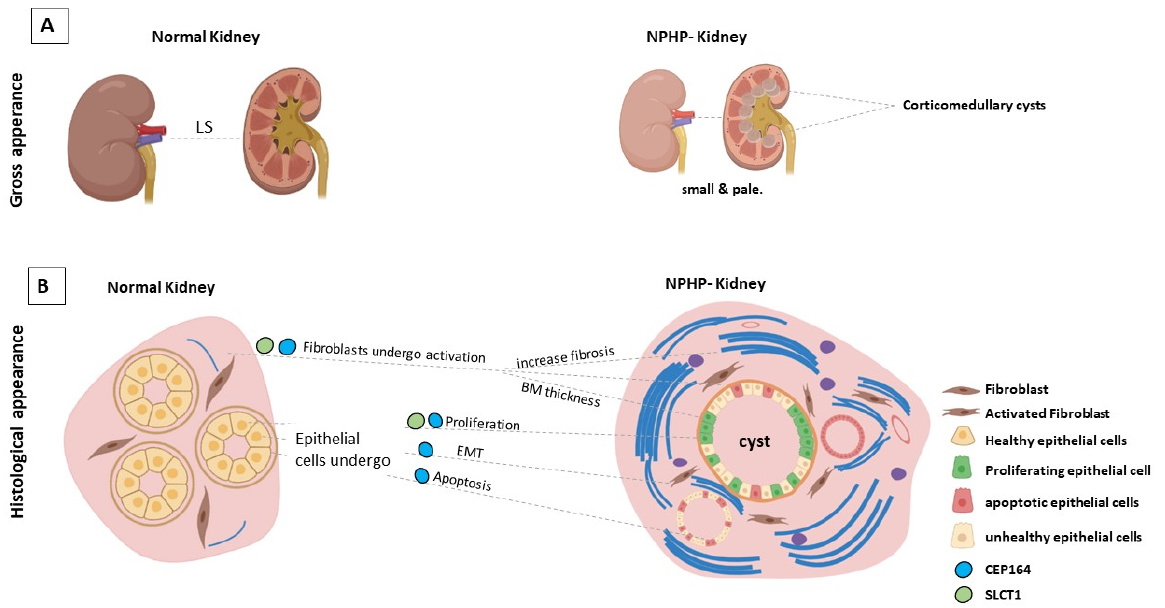
Figure 2. ( A ). Longitudinal section of a diseased NPHP kidney compared with a section of a normal kidney. Cysts form at the corticomedullary junction. ( B ). Diagram depicting a cross section of the kidney, illustrating the multiple cellular stress changes associated with a SCLT1 and CEP164 deficiency during NPHP development. Image was created by BioRen- der.